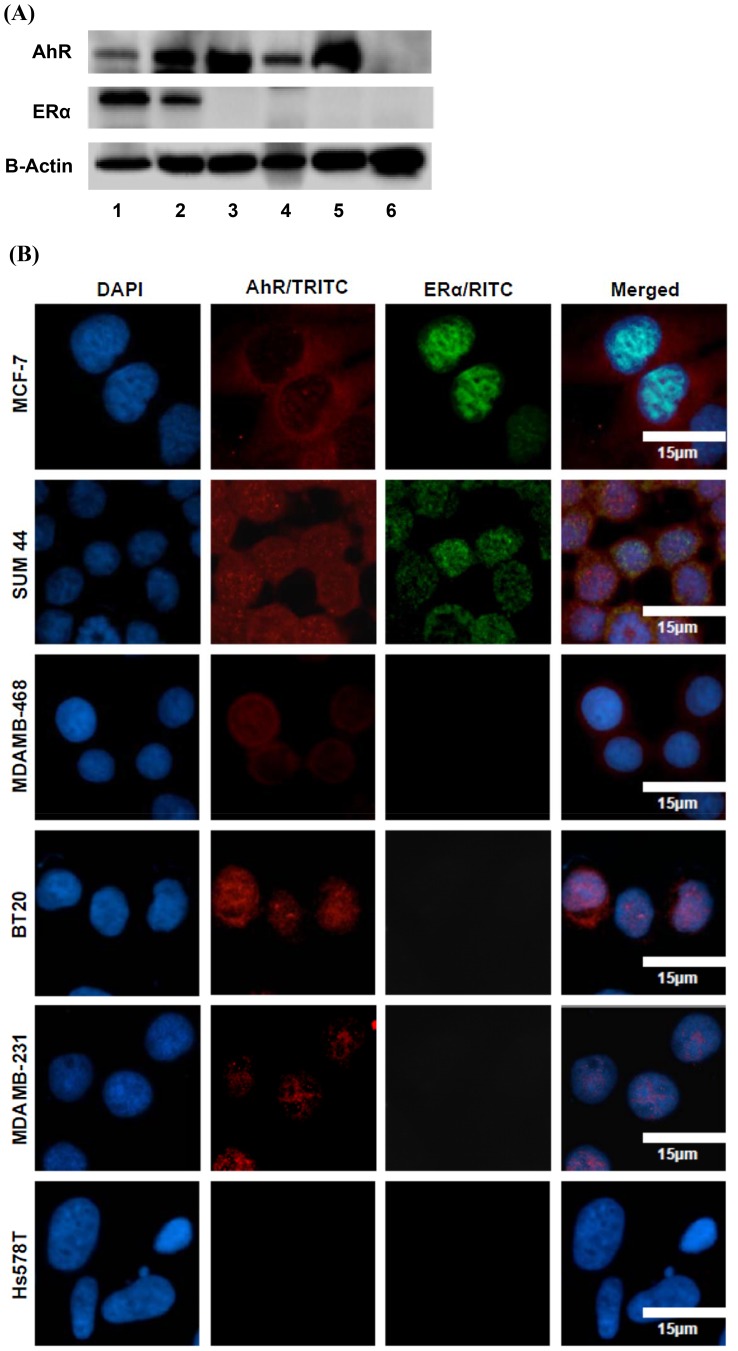
Cytoplasmic localization of the AhR was associated with the sensitivity of breast cancer cell lines to AFP464.(A) Western blot shows constitutive expression of ERα and AhR in AFP464-sensitive (MCF-7, SUM44, MDA-MB-468, and BT20) and -resistant (MDA-MB-231, and Hs578T) human breast cancer cell lines (Lanes 1–6, respectively). (B) Immunofluorescence staining of the cellular localization of ERα and AhR in AFP464-sensitive and -resistant human breast cancer cell lines. The blue DAPI, red TRITC, and green FITC staining indicates positive staining for the nucleus, AhR, and ERα, respectively.